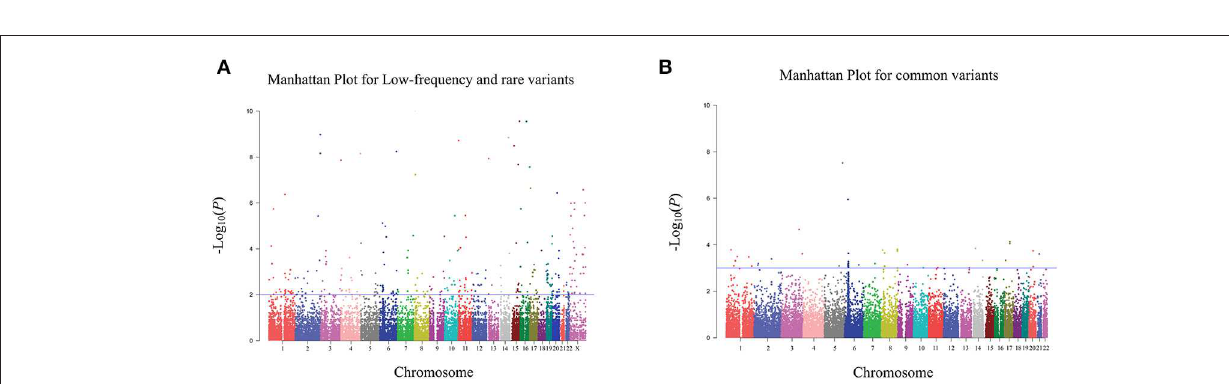
Frontiers in Oncology |